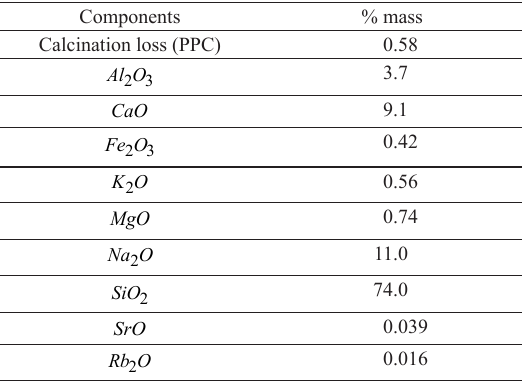
Table 4. Glass powder chemical